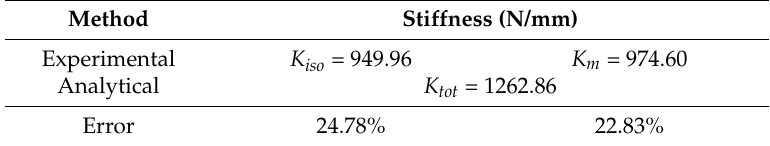
Table 6. Comparison between experimental and analytical stiffness values of the analyzed